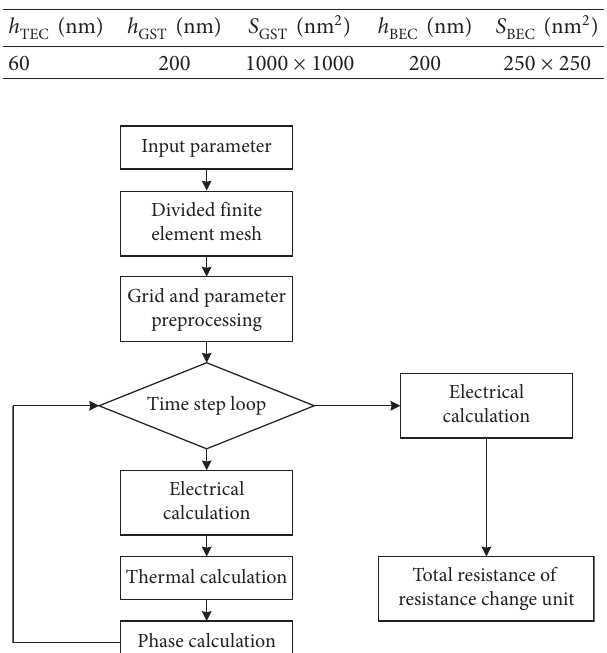
Table 1: Resistance change unit structural model